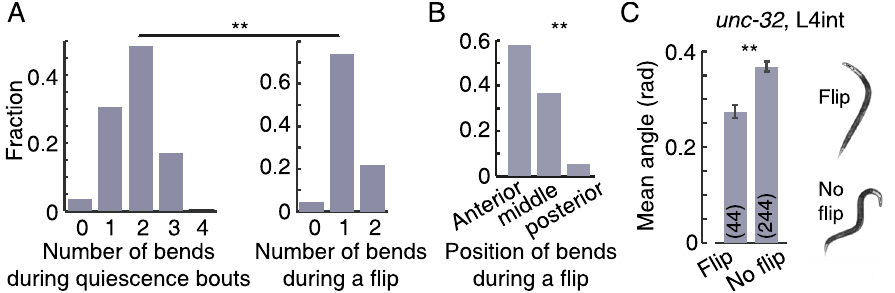
Figure 3. Flips preferentially occur during quiescence bouts with one bend. (A) Left: during quiescence bouts, animals typically exhibit 1–3 body bends. Right: the number of observed body bends during the initiation of successful flips. If the flips were performed independently of the overall body-posture then we would expect the distribution of bends at flip-initiation to mirror the one measured during quiescence bouts in general. In contrast, we found that the two distributions were significantly different (asterisks denote p , 0.01), and that the majority of flips were initiated from a single bend posture. (B) When a flip was generated, the position of the bend along the body was preferentially in the anterior- and mid-body regions. The distribution of positions was found to be significantly different from a uniform distribution (asterisks denote p , 0.01). Data for all histograms was taken from N=22 animals during the first half of L4leth. (C) Left: the mean absolute body angles of late L4int unc-32 mutants, calculated for 100 sec intervals (see methods). Error bars depict 6 s.e.m and the numbers of 100 sec intervals that were averaged in each case is denoted in parenthses (asterisks denote p , 0.01). Right: two examples of postures, one from an interval in which a flip was detected (top) and the other from an interval in which a flip was not detected